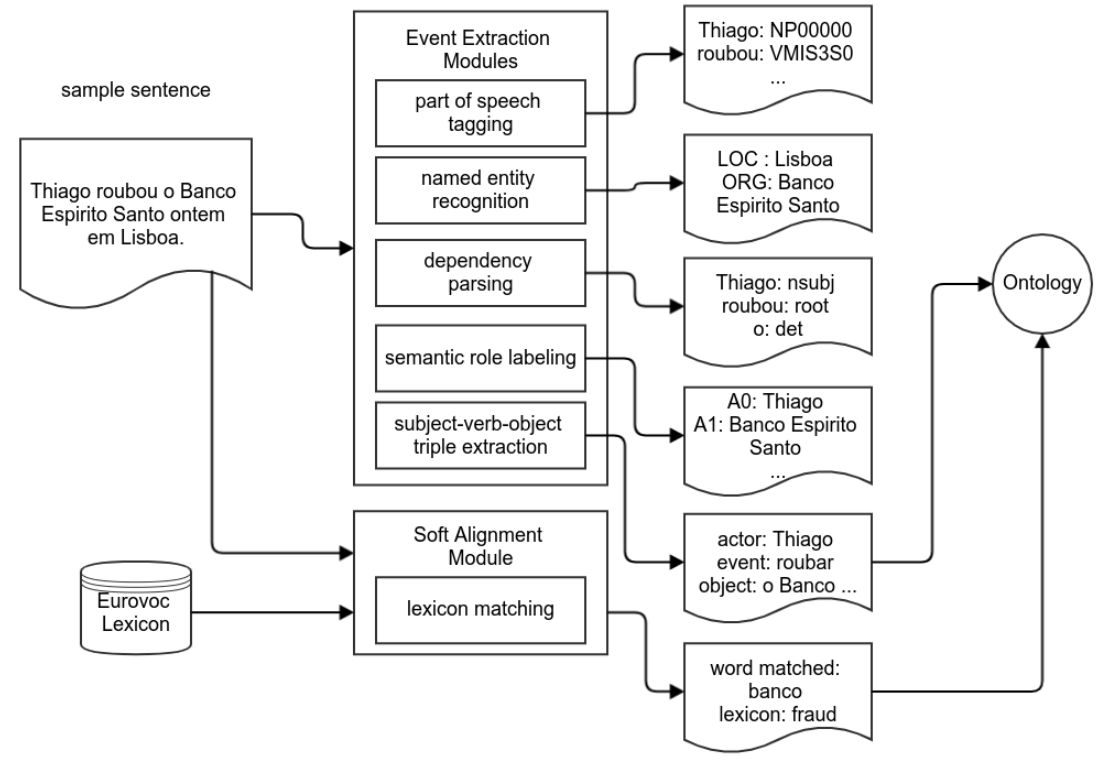
Figure 1. System